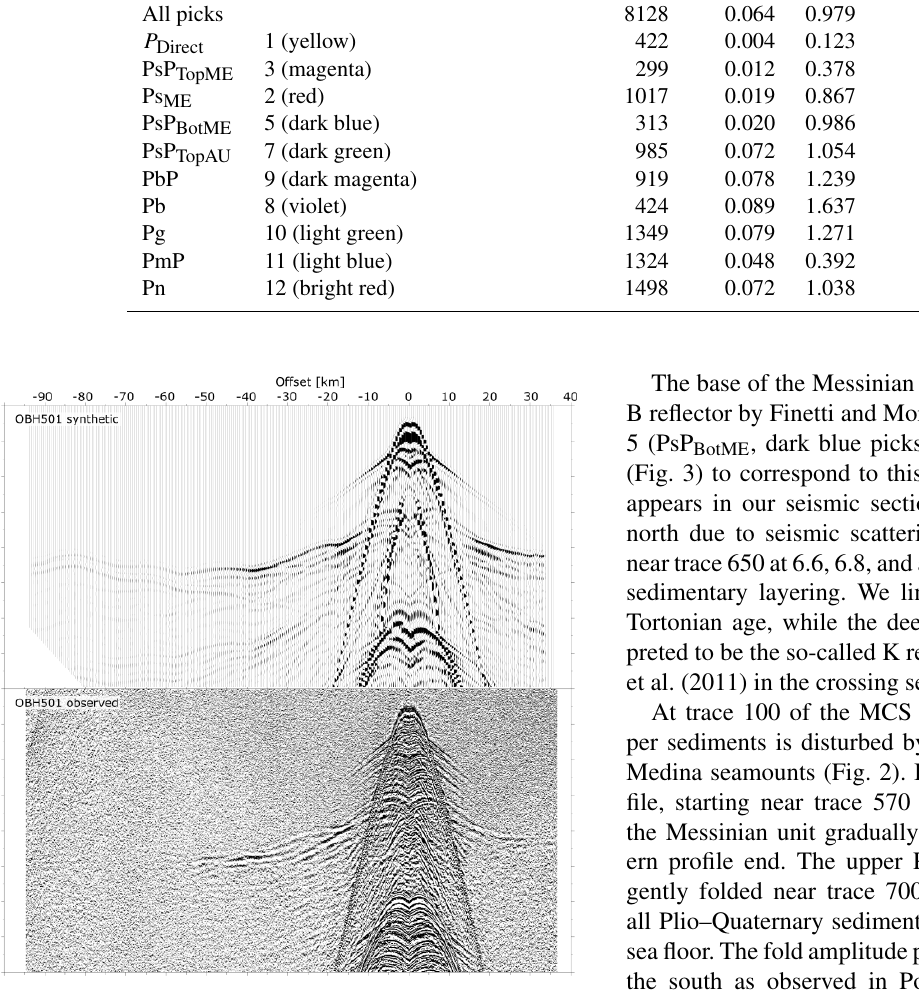
Figure 6. (a) Synthetic seismogram of OBH501 based on the fi- nal velocity model. (b) Original bandpass-filtered seismogram of